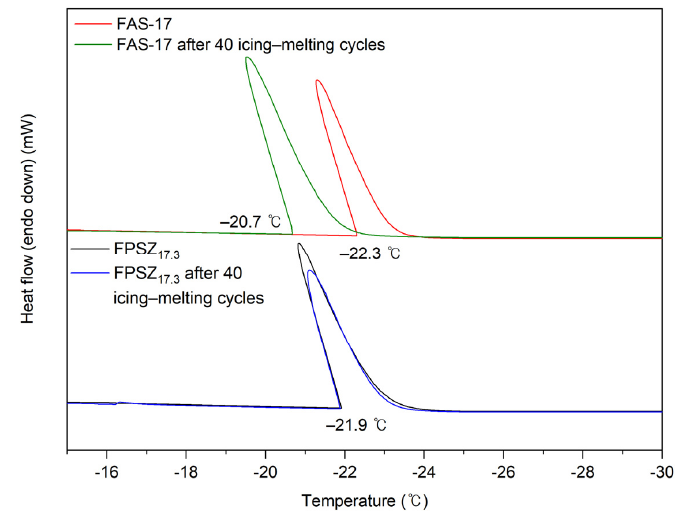
Figure 8. DSC curves of supercooled water droplets dropped on the FPSZ 17.3 - and FAS-17–coated Al surfaces before and after 40 icing–melting cycles.